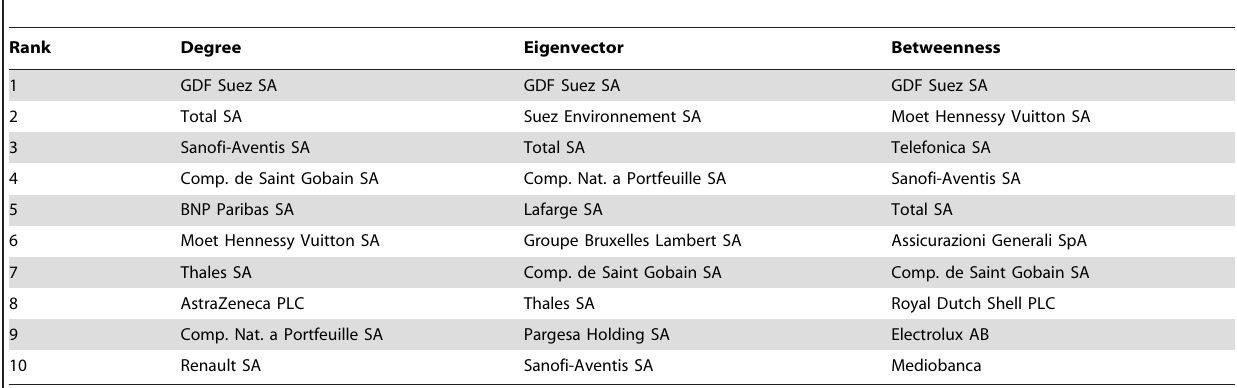
connected to well-connected others and have a high betweenness at the same time; they can be called ‘‘hubs’’. The upper left side of the figures groups firms that are directly connected to central actors but are not themselves on the main shortest paths. Firms lying in the lower right region of the figures are the ‘‘brokers’’, i.e. the firms that stand on the shortest paths and bridge different parts of the network but not connected to well-connected others. French firms stand out both in terms of eigenvector as well as betweenness centrality. In 2005 there is still a batch of German firms in the top left quadrant of Fig. 4 (left), but by 2010 the top half of the figure is occupied by French firms only (Fig. 4 right). The decrease in hierarchy as already noted in the previous paragraphs is also illustrated by the more concentrated and overall lower scores on eigenvector centrality in 2010 as compared to five years before. Finally, there is the group of firms with low eigenvector scores (below .25) but high betweenness (above .25). These firms are perhaps the more transnational oriented ones, partly also because their home countries have smaller business communities and hence less opportunities to interlock. Tables 2 and 3 further reveal that the core of the more central firms is not entirely stable between 2005 and 2010: firms move in and out the most central areas. Table 3. Top 10 ranked firms with respect to three different measures of centrality – Year